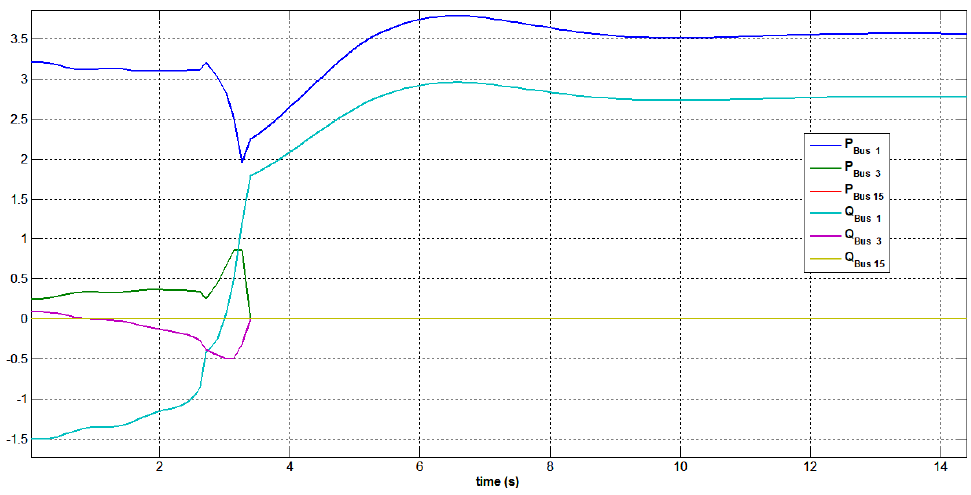
Figure 32. Active and reactive power at swing generator bus 1, PV bus 3, and the photovoltaic bus 15 after disconnection of SPVGP.